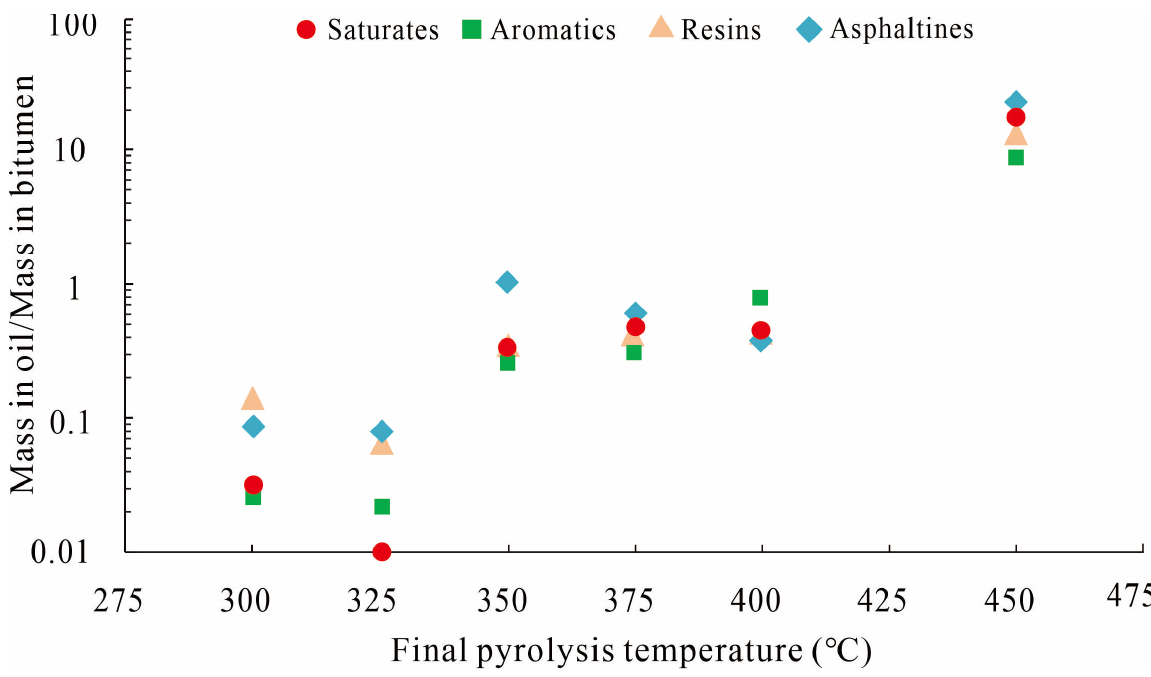
Figure 13. Distribution variations of SARA fractions in oil and bitumen with increase in thermal Figure stress.